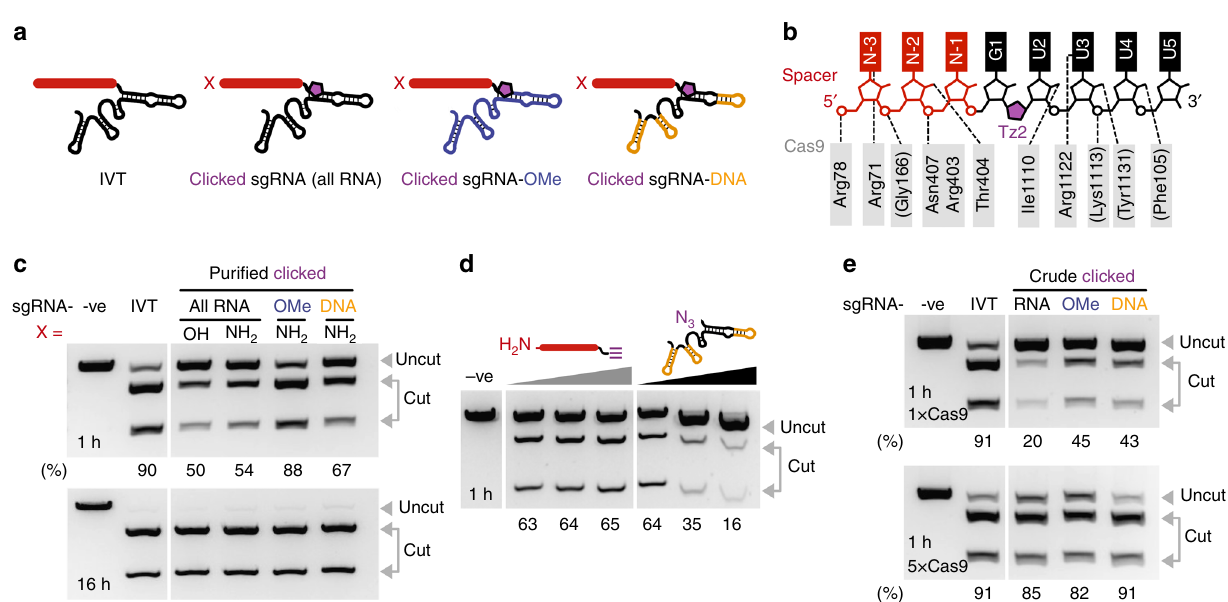
Fig. 2 Clicked sgRNA constructs and their in vitro DNA cleavage activity. a illustrates the constructs tested (full sequences targeting plasmid pBR322 site 1 are in Supplementary Data 1). Note that when X = NH 2 , the modi fi cation is a 5 ′ -C6-NH 2 linker, and that when X = OH, there is no 5 ′ modi fi cation, only a 5 ′ -OH group. b details the intermolecular interactions between Cas9 and the sgRNA based on PDB: 4OO8 (ref. 37 ), as well as the position of the triazole linkage. Note that the spacer is red, the Cas9-binding RNA is black and the Tz2 linkage is purple. c shows the activity of these constructs in Cas9-mediated DNA cleavage relative to in vitro transcribed (IVT) sgRNA at 1 and 16 h time points using 1× Cas9. d shows the inhibitory effects of the 79-mer but not the ~20-mer on Cas9 activity (0, 2 and 4 equivalents relative to clicked sgRNA-DNA, sequences can be found in Supplementary Data 2). e demonstrates that desalting CuAAC clicked constructs, without additional PAGE puri fi cation, still enables DNA cleavage, and that increasing Cas9 concentration fi